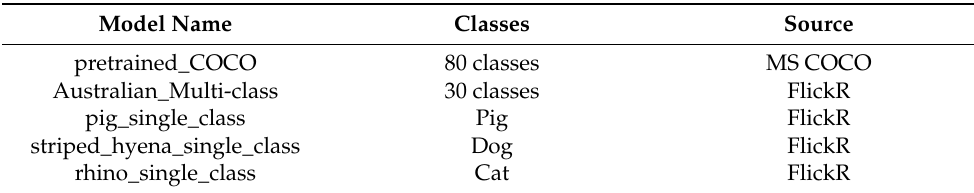
Table 1. Summary of pretrained models included with U-Infuse